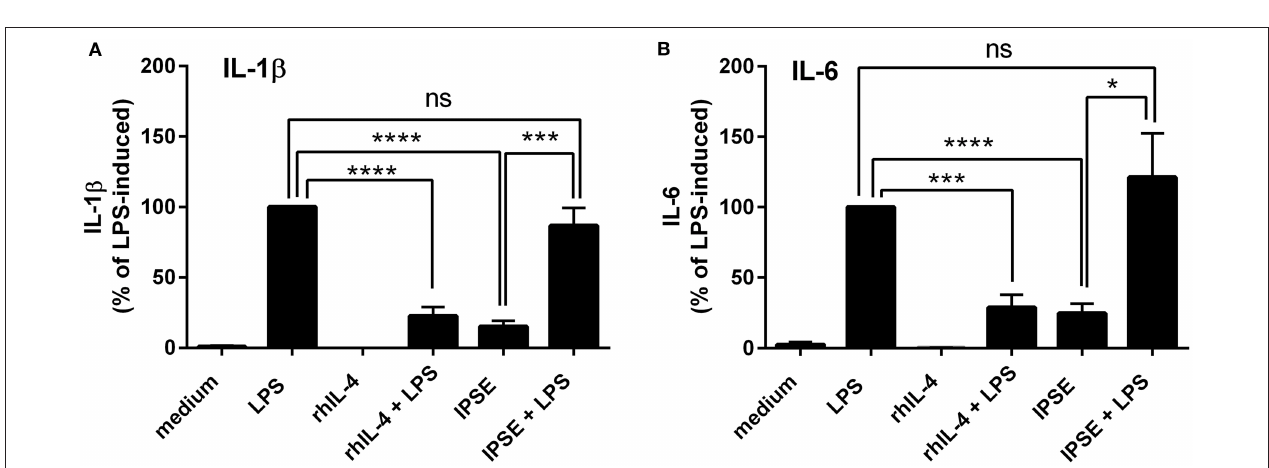
FIGURE 2 | IPSE/alpha-1 had limited direct effect on the pro-inflammatory cytokine release of monocytes. IL-1 β (A) and IL-6 (B) released from human monocytes stimulated with LPS, rhIL-4, IPSE/alpha-1 or combinations thereof. While rhuIL-4 had a significant inhibitory effect on the LPS-induced IL-1- β and IL-6 release from monocytes, IPSE/alpha-1 alone had only very little (IL-1 β ) or virtually no (IL-6) direct effect on LPS-activated monocytes with respect to inhibition of cytokine release. Pro-inflammatory cytokine release directly induced by IPSE/alpha-1 is the result of small amounts of LPS in E. coli -expressed IPSE/alpha-1. Data are presented as mean ± SEM, n = 7. Statistics were performed with the paired t -test; ns, not significant, * p < 0.05, *** p < 0.001, **** p < 0.0001.